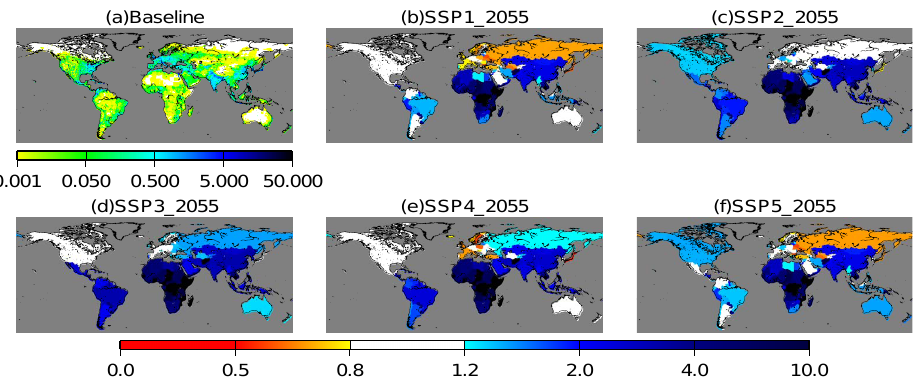
Fig. 13. Global distribution of withdrawal-based potential municipal water demand. (a) Baseline year (circa 2000) (m 3 s − 1 ) , (b–f) Change (ratio) from the baseline year for SSP1–5 in